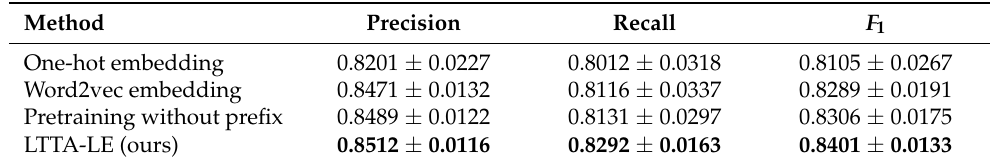
Table 4. Experimental results of different label-embedding methods on the Arxiv dataset ( ± indicates standard